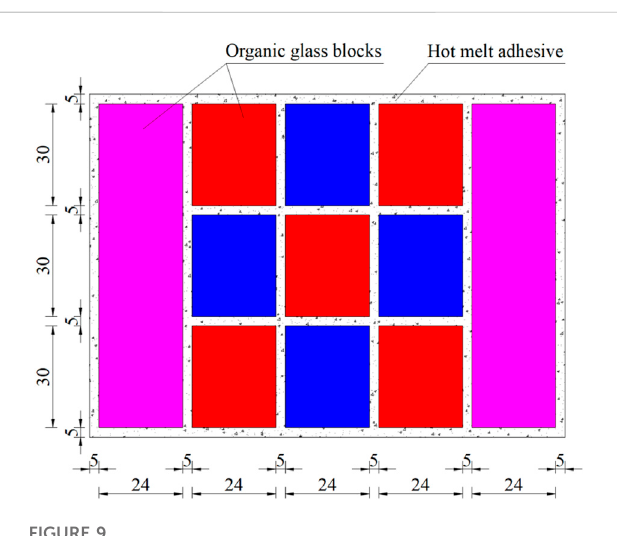
FIGURE 9 Relative position relation between organic glass blocks and hot melt adhesive (mm).